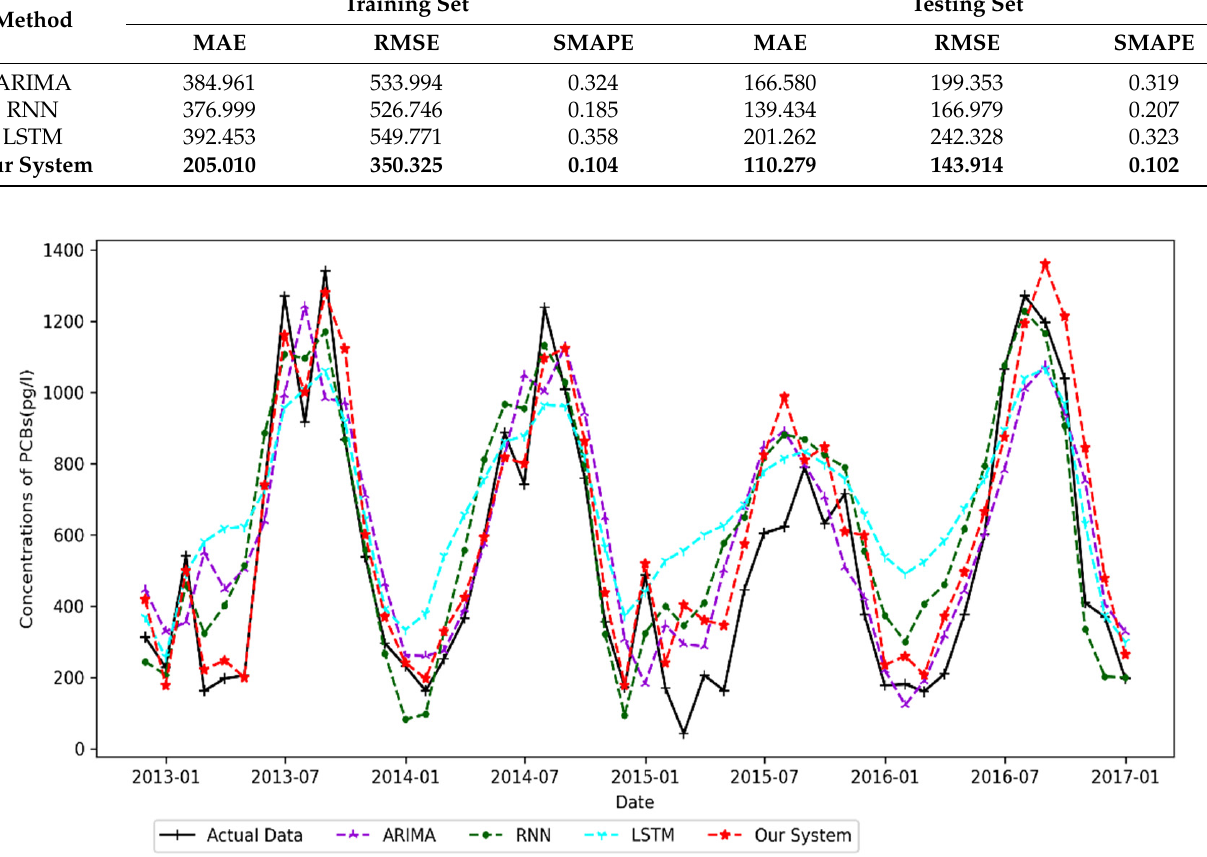
Table 7. Comparison of index values of each model on Eagle Harbor